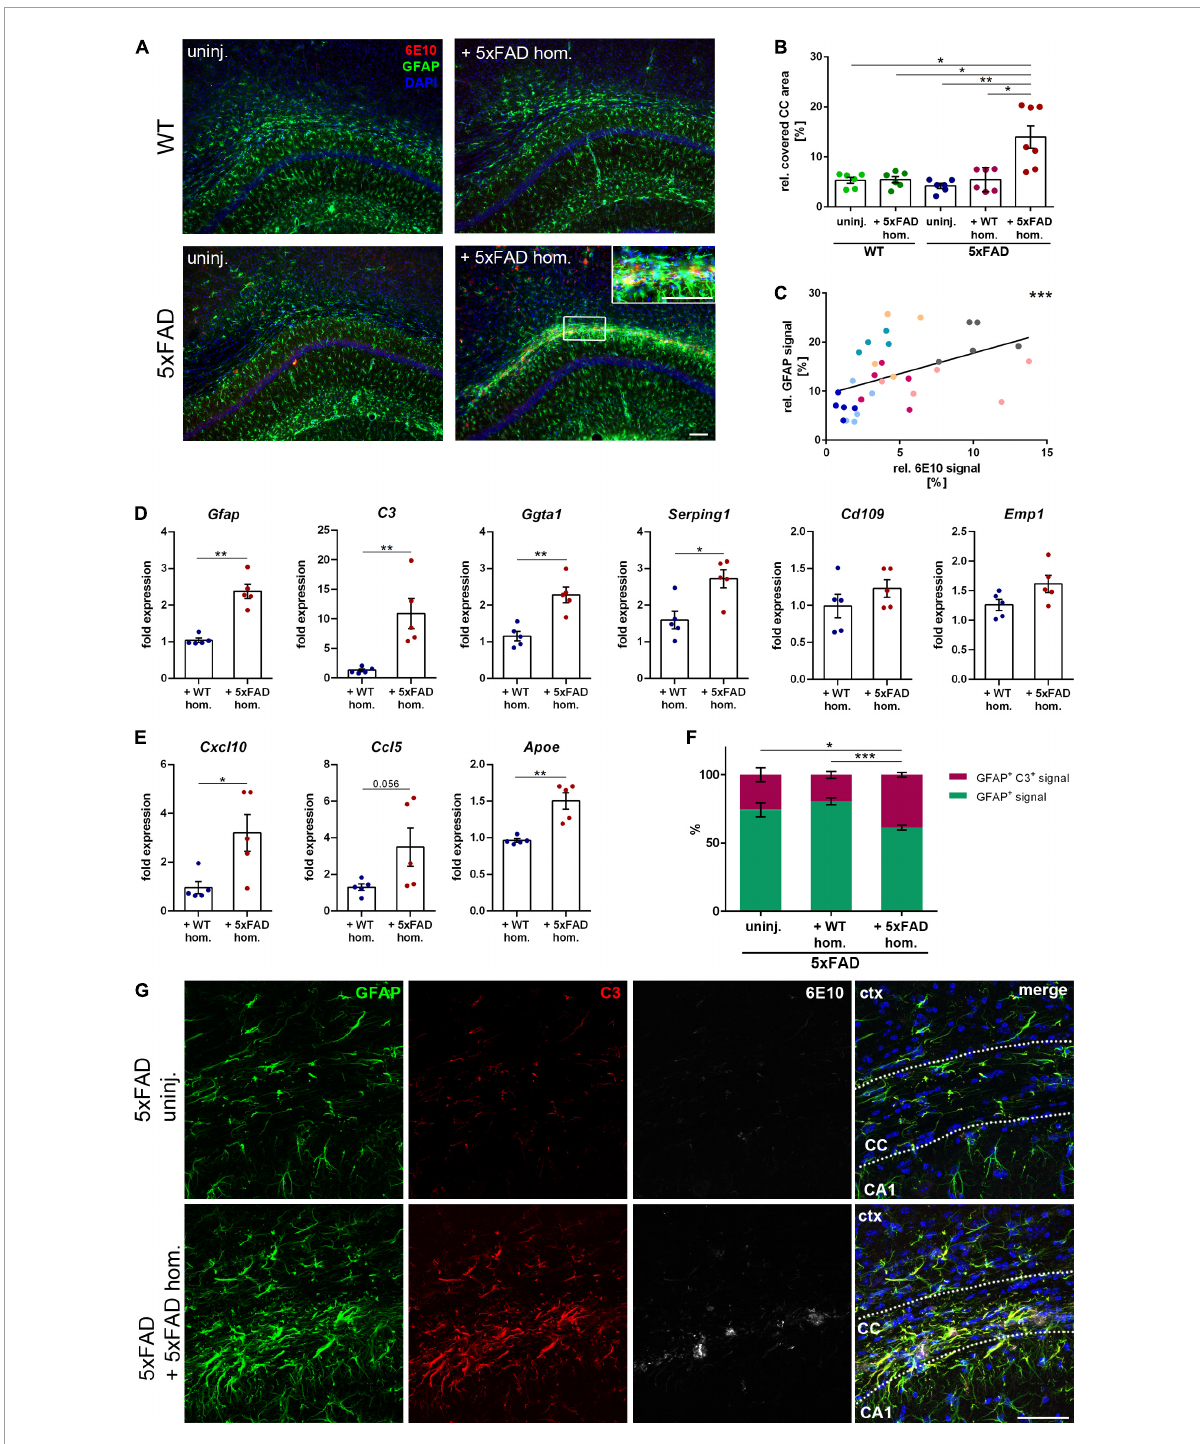
FIGURE3 Reactive astrogliosis in the corpus callosum (CC) adjacent to the amyloid-beta peptide (A β ) seeding. (A) Representative fluorescence micrographs of GFAP (green) and 6E10 (red) of 5xFAD brain homogenate-injected or uninjected 4-month-old WT and 5xFAD mice. Scale bar for overview and inset 100 µ m. (B) Analysis of the GFAP signal relative to the CC area. n = 6–7 mice with n = 4–5 sections analyzed per animal. Each symbol represents data from one animal. Mean ± SEM, Kruskal–Wallis test followed by Dunn’s multiple comparison test, * p < 0.05, ** p < 0.01. (C) Pearson correlation plots of the amount of A β seeding (%) relative to GFAP signal (%) in 5xFAD mice injected with 5xFAD homogenate. Each symbol represents data from one section and each color represents one mouse. r = 0.5752, *** p < 0.0005. (D) RT-qPCR of the astrocyte-associated genes Gfap , C3 , Ggta1, Serping1 , Cd109, and Emp1 in 5xFAD mice injected with either WT ( n = 5) or 5xFAD ( n = 5)